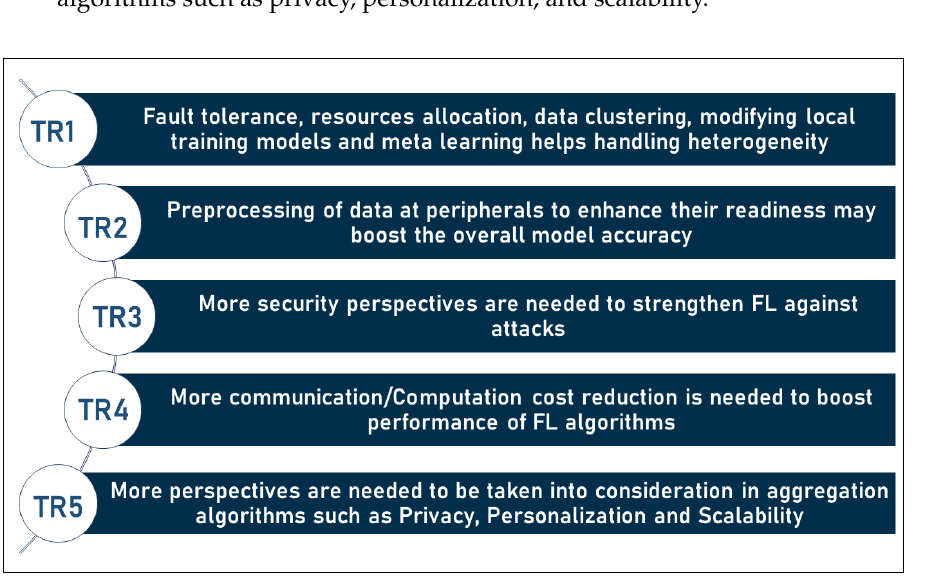
Figure 9. Research topics that may serve as solutions to the challenges in the domain.